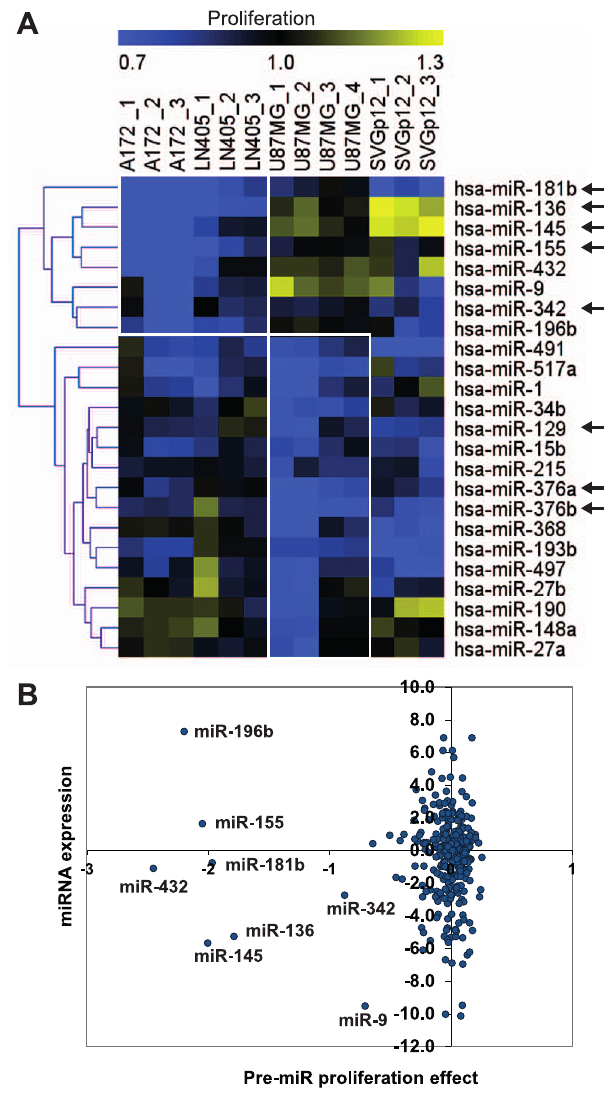
Figure 1. Functional screening for miRNAs affecting glioma cell line proliferation after overexpression of precursor miRNAs. A) Hierarchical clustering of repeating hits from the miRNA pre-miR functional proliferation primary screening using the Euclidean method in MeV 4.8 (row and column normalized data) [10,11]. In the linear relative scale, 1.0 denotes no change in proliferation (100%), and 0.7 denotes 30% reduction in proliferation. Each screening was performed in three to four biological replicates. Arrows denote miRNAs that were selected for further validation. B) Integration of miRNA expression data and primary screening functional data for the A172 glioma cell line shown in a scatter-plot (log 2 mean data on both axes). MiRNA expression is presented as the ratio of expression in the cell line compared to the normal brain reference miRNA (log 2 ). Some miRNAs highlighted with arrows in panel A are marked in panel